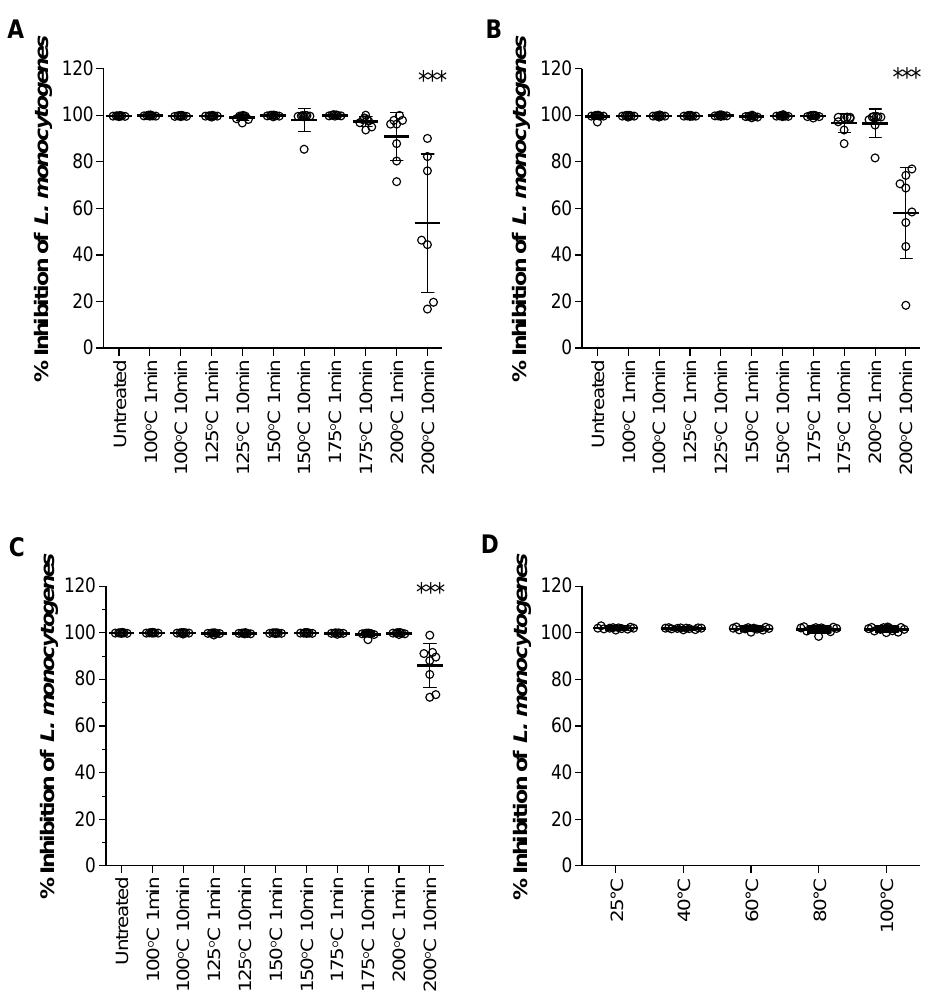
Figure 4. Antimicrobial activity of peptide-treated cellulose against L. monocytogenes (5 × 10 6 cells/cm 2 ) after exposure to ‘dry’ temperature ranges at 1 and 10 min Three peptide analogue mixtures were tested: ( A ) Trp supplemented culture extract, ( B ) Phe supplemented culture extract, and ( C ) Trc mix. ( D ) Antimicrobial activity of Trc mix-treated cellulose after exposure to ‘wet’ temperature ranges. Data represents the mean and SD of 9 repeats. Statistical analysis between untreated as control and the other conditions were determined with One-way ANOVA and Bonferroni’s Multiple comparison post-test; *** p < 0.001.